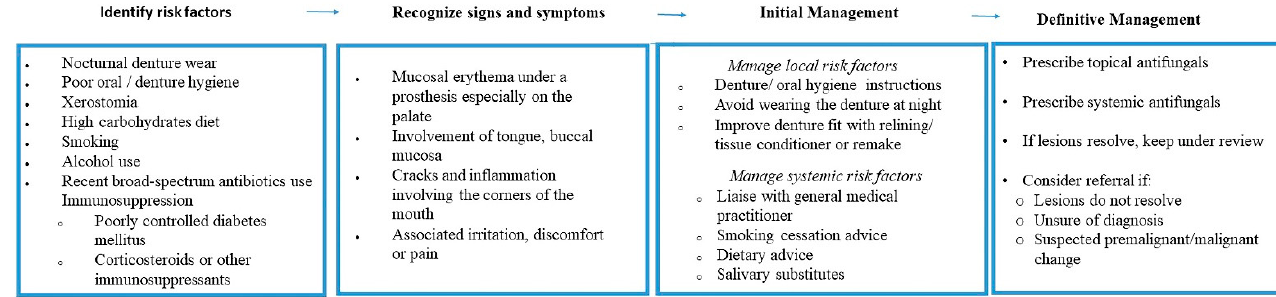
Figure 6. A schematic management of